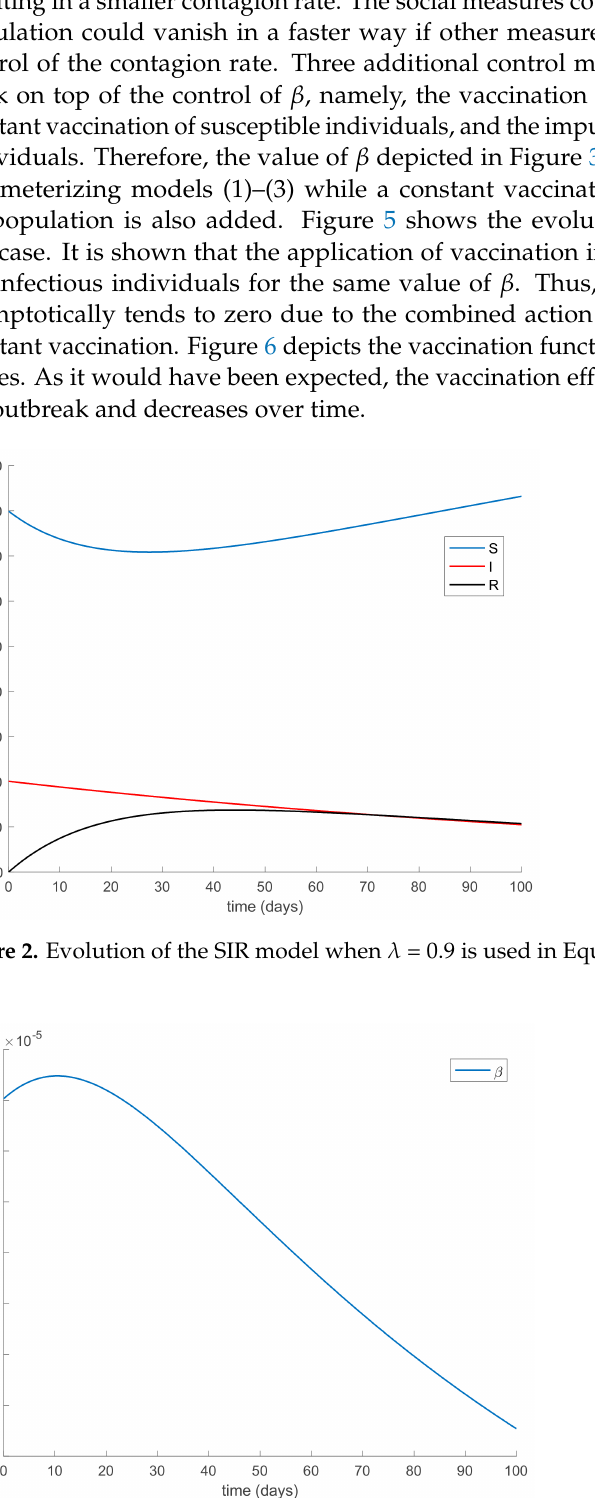
Figure 3. Evolution of β when it is selected using Equation (30) with λ =